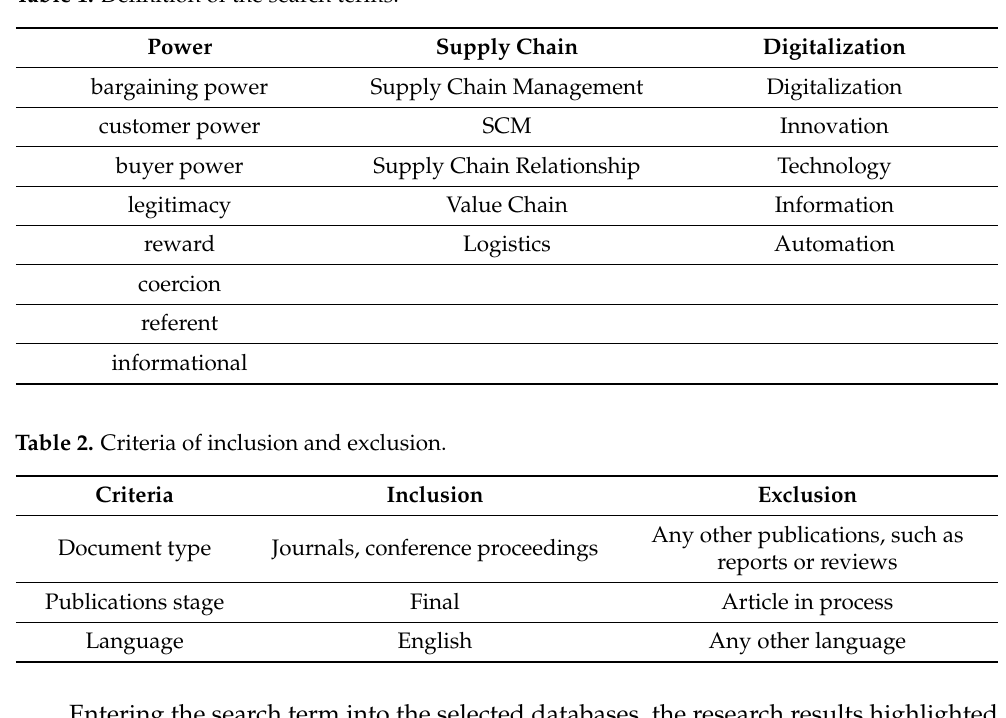
Table 1. The different synonyms of each column are summarized by the logical operator of